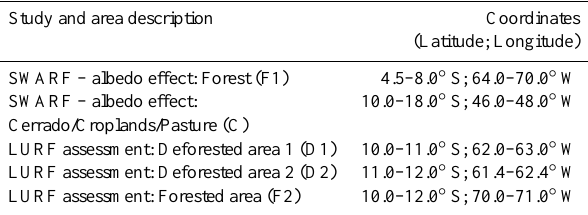
Table 1. Geographic locations of (i) forest (F1) and cer- rado/croplands/pasture (C) regions used for the study of the effect of the surface albedo in the daily SWARF; and (ii) the deforested (D1 and D2) and forested (F2) regions selected for the LURF as- sessment. The surface properties of those areas were used in the SBDART radiative transfer code to obtain the 24-h SWARF and LURF